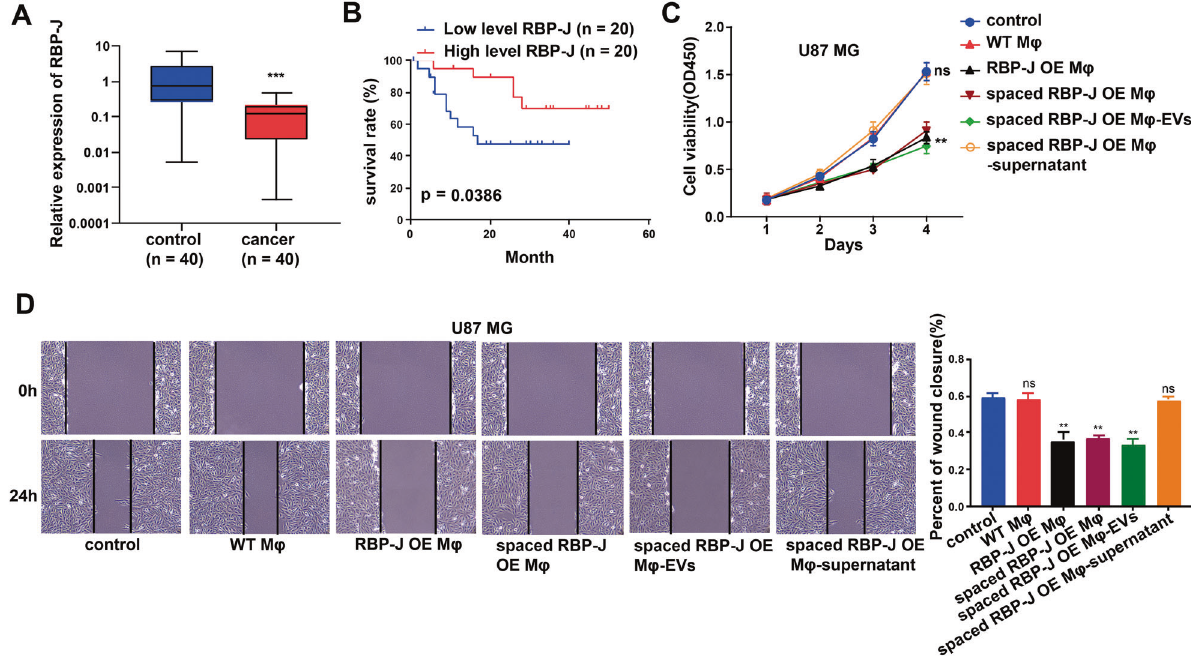
Fig. 1 RBP-J OE M φ inhibit proliferation and invasion of glioma cells through extracellular vesicles. A RBP-J expression in the microphages from glioma tissues and paired normal tissue samples ( n = 40) using qRT-PCR. B Kaplan – Meier analysis of overall survival of glioma patients strati fi ed by RBP-J expression. C Cell proliferation in glioma cell lines U87 MG co-cultured with WT M φ , RBP-J OE M φ , spaced RBP-J OE M φ , spaced RBP-J OE M φ -EVs or RBP-J OE M φ -supernatant was assessed by CCK-8. D Wound healing assay is performed to detect cell migration (bar = 100 μ m). All experiments were performed three times. ** P < 0.01, *** P < 0.001 for statistical differences, EVs Extracellular vesicles, ns no signi fi cance. Table 1. Association between RBP-J expression in the macrophages from the glioma tissue samples and clinicopathological features of glioma. Feathers Number High Low P value All cases